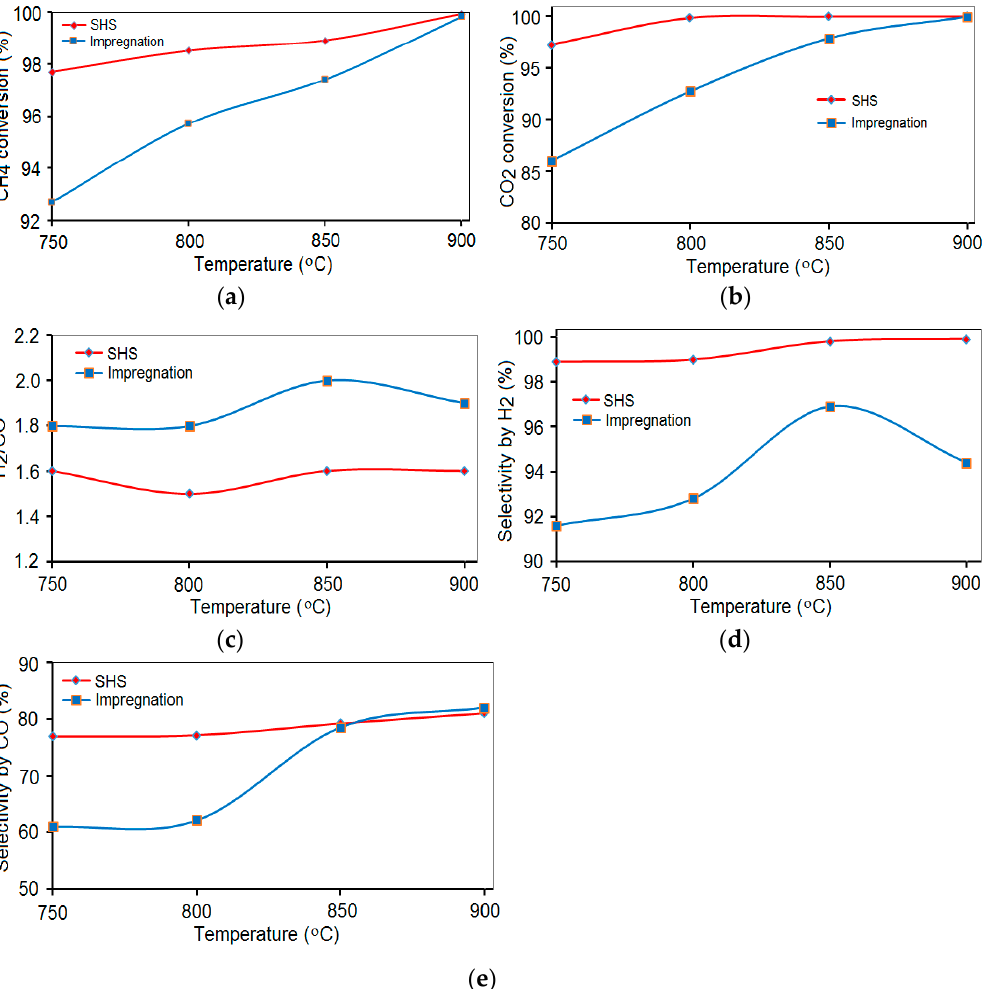
Figure 12. Influence of reaction temperature and method of catalyst preparation on the CH 4 ( a ) and CO 2 ( b ) conversion, H 2 /CO ratio ( c ), and selectivity by H 2 ( d ) and CO ( e ).